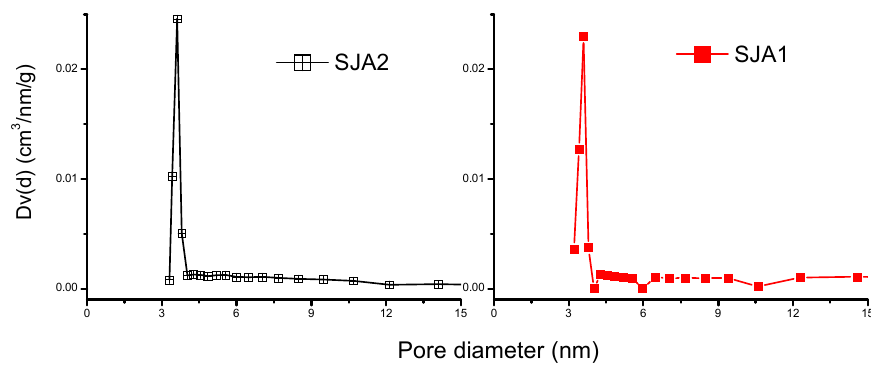
Figure 3. Pore size distribution of soils samples.